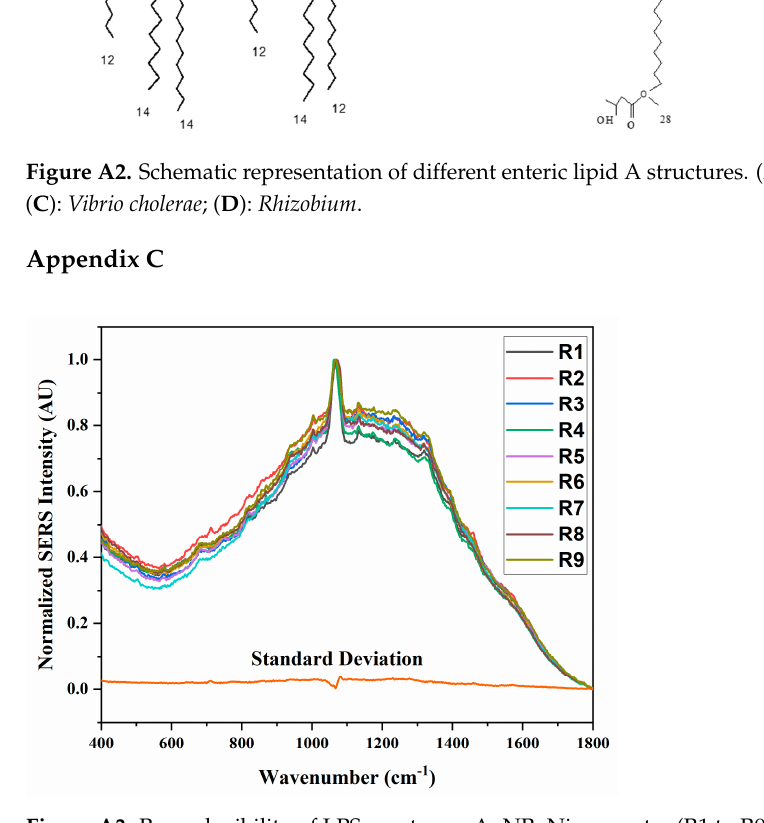
Figure A3. Reproducibility of LPS spectra on AgNR. Nine spectra (R1 to R9) are shown for the same LPS as measured at different locations on the AgNR substrate.